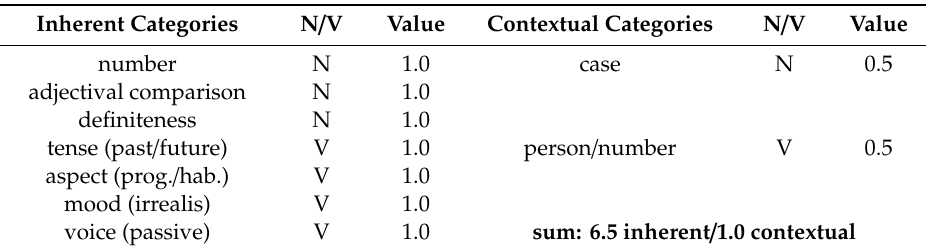
Table 5. The grammatical categories of modern English.